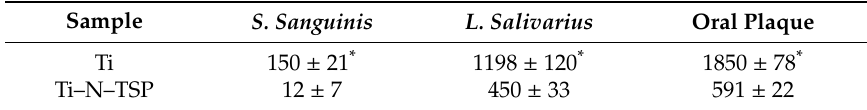
Table 3. Value of the colony-forming unit (CFU) cm − 2 of S. sanguinis , L. salivarius and oral plaque after 2 h of incubation on titanium (Ti) and TESPSA-modified (Ti–N–TSP) samples. Asterisk means statistical significant differences (P < 0.05). (mean ± standard deviation (SD)).